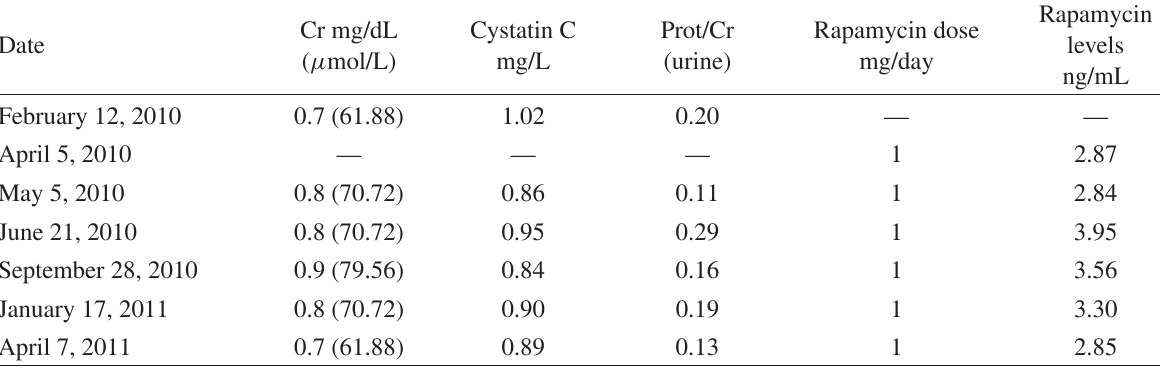
TABLE 2: Laboratory values of a TSC patient with LAM treated for 12 months with